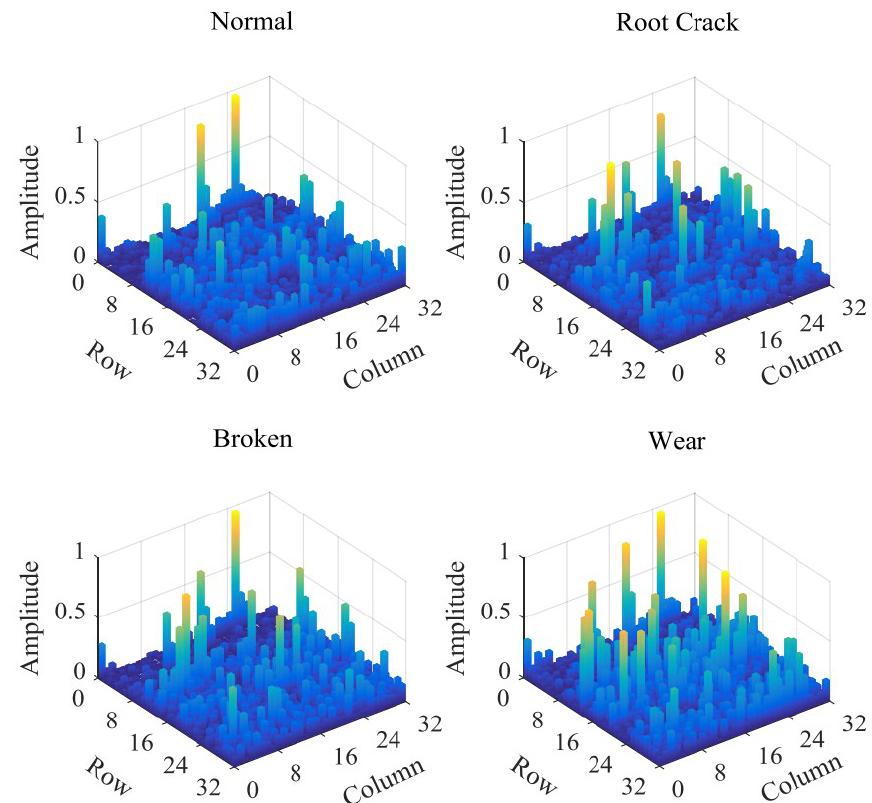
Figure 11. Feature matrix of four gear states.